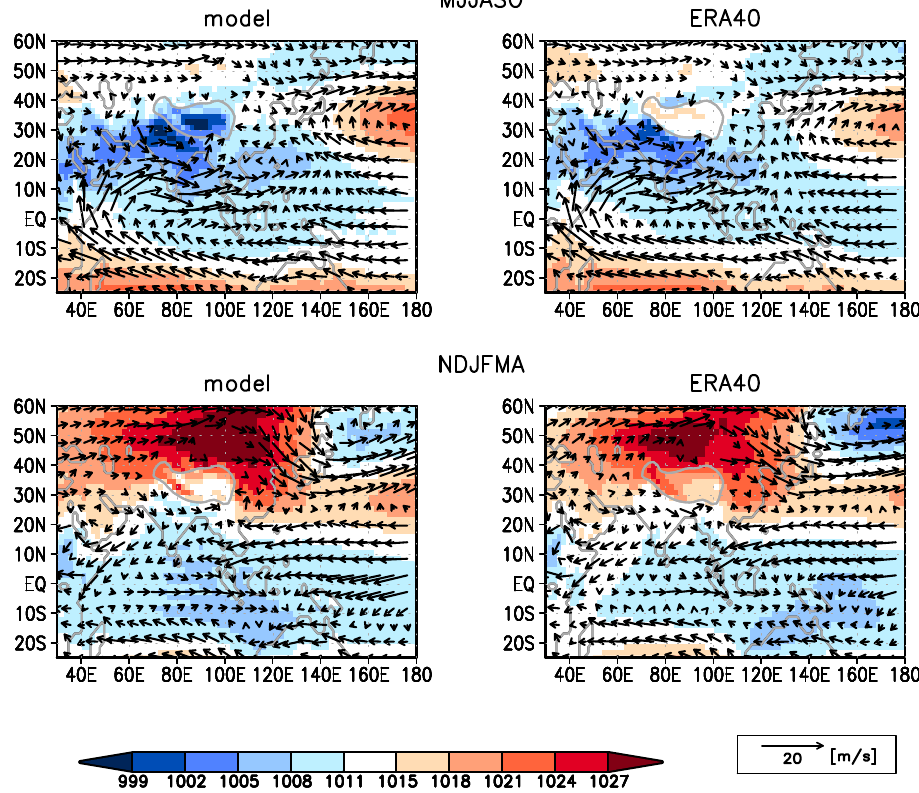
Fig. A3. Simulated mean sea level pressure in hPa, shaded, and 850hPa wind circulation in ms − 1 , vector, compared to ERA40 reanalysis data (Simmons and Gibson, 2000). Values are displayed as averages over the monsoon season (upper panel) and the dry/cold season (lower panel). Wind vectors are not shown in regions where the model orography exceeds 1500m. Values are taken from the CTRL